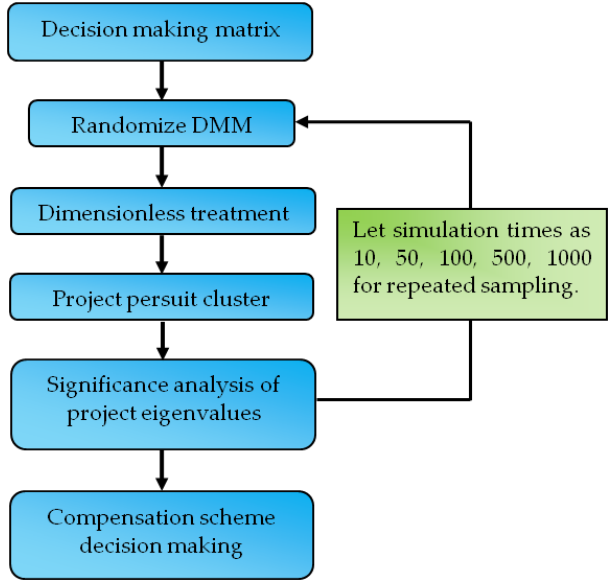
Figure 1. Diagram of multi-attribute decision making for ecological compensation.